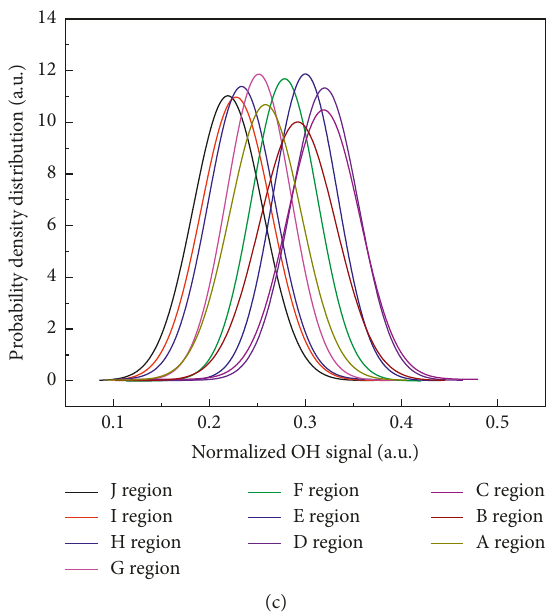
Figure 7: Probability density distribution of oscillation data of various regions, corresponding to the conditions (a) A1, (b) A2, and (c) A3.